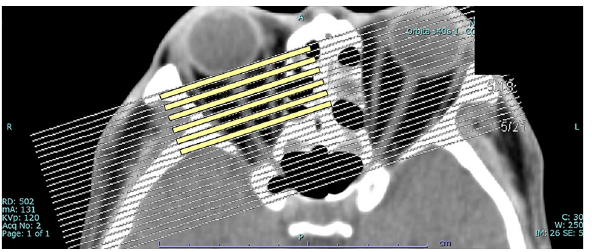
Figure 3. Coronal scans in a paraxial plane 90° to the orbital axis were reconstructed from the axial scans ( a ). Sequential six slices (2-mm thickness) from the posterior margin of the globe toward the orbital apex on the coronal scans were used ( b ).